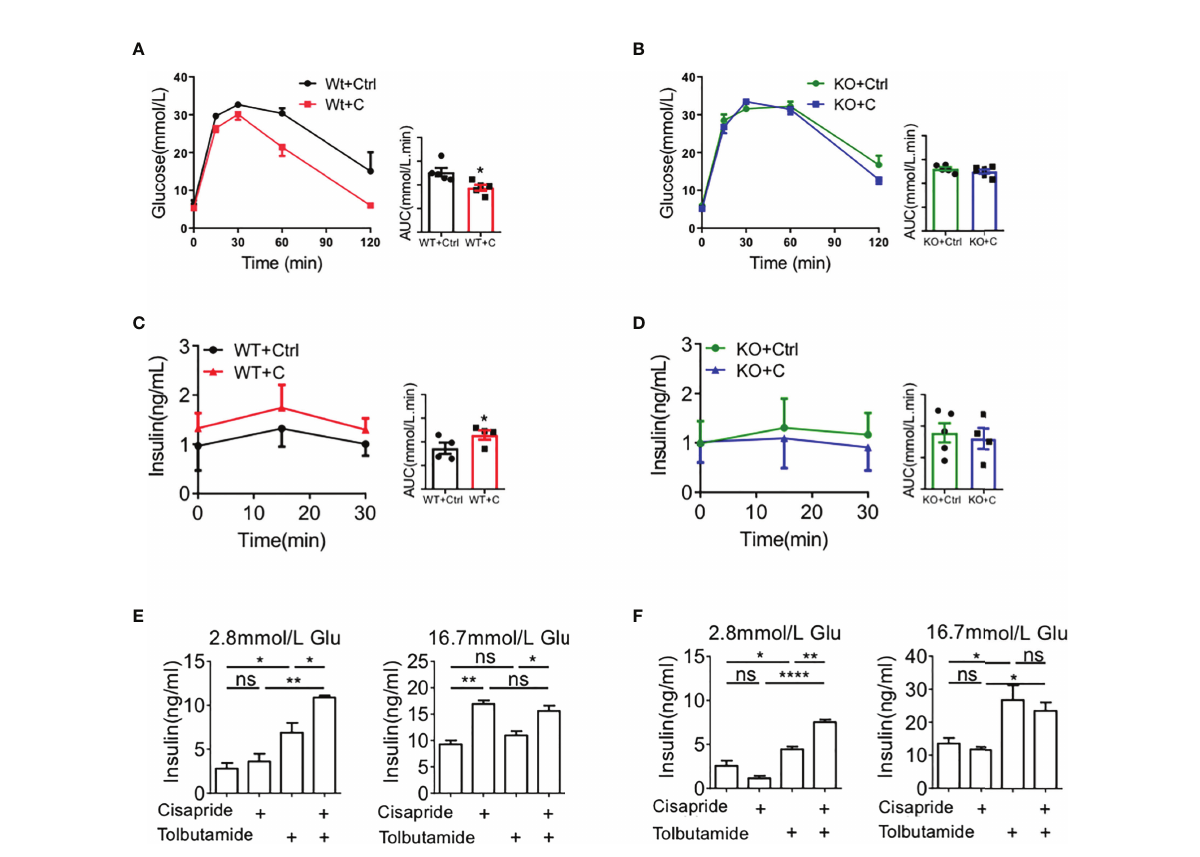
FIGURE 7 Effects of cisapride on WT and Kcnh6- b -KO mice in vivo and in vitro (A, B) Blood glucose and plasma insulin levels in WT and cisapride-treated WT mice. (C, D) Blood glucose and plasma insulin levels in Kcnh6- b -KO and cisapride-treated Kcnh6- b -KO mice. (E) Islets from WT and (F) Kcnh6- b -KO mice were treated with 10 mM cisapride or the vehicle (control) while being stimulated with 25 mM glucose for 30 min. The secreted insulin level in the supernatant was normalized to the total insulin content in the islets. n=4 for each group. * P < 0.05, ** P < 0.005 vs. Ctrl. Statistical comparisons were calculated using the Mann – Whitney U test (A – F) . NS, Non Signi fi